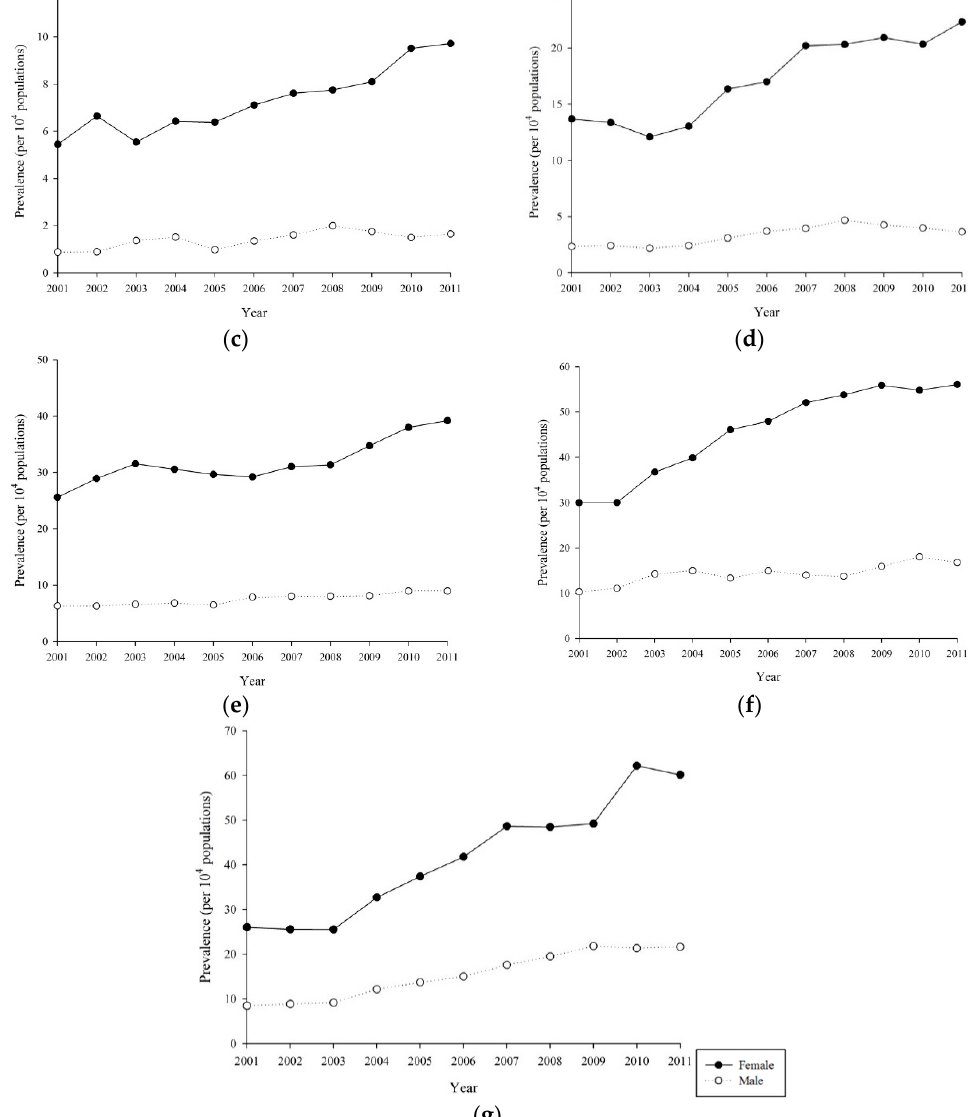
Figure 1. Prevalence of Rheumatoid Arthritis from 2001 to 2011 by age groups: ( a ) 10–19 years old; ( b ) 20–29 years old; ( c ) 30–39 years old; ( d ) 40–49 years old; ( e ) 50–59 years old; ( f ) 60–69 years old;